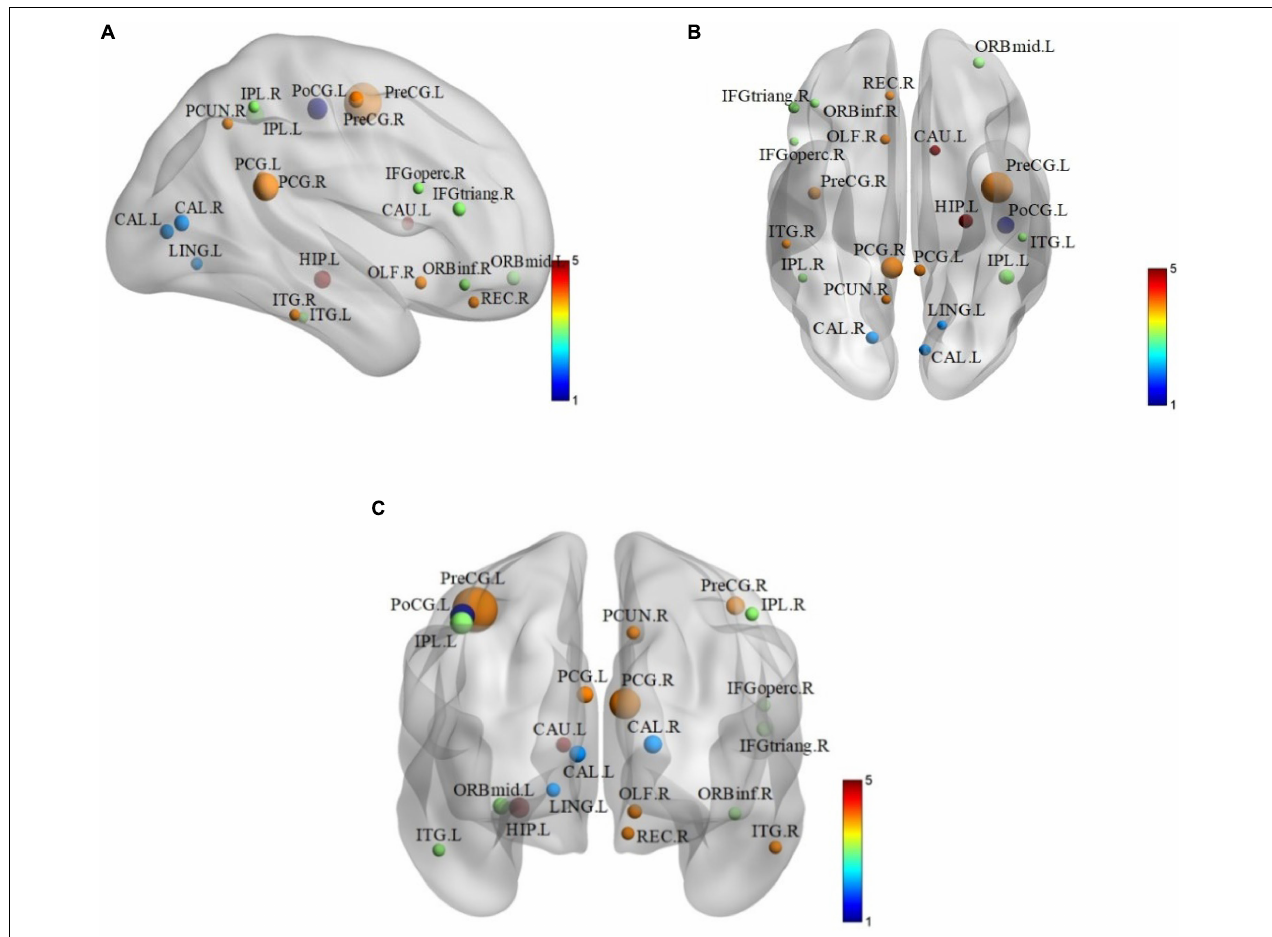
FIGURE 5 | The layouts of discriminative brain regions. (A) Coronary figure. (B) Axis figure. (C) Sagittal